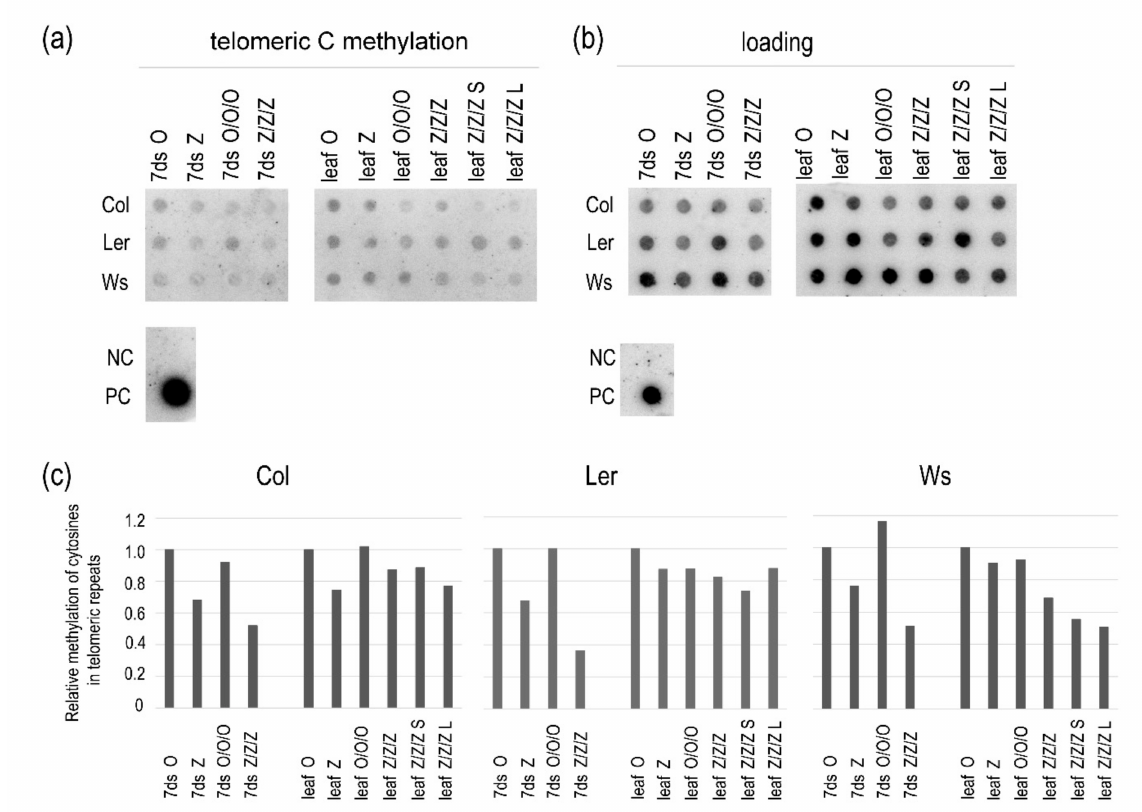
Figure 5. Relative levels of methylated cytosines in telomeric repeats in the first and third generations of 7-day-old seedlings (7ds) of A. thaliana plants germinated on control medium or exposed to 250 µ M zebularine, and in leaves of plants grown from these seedlings in soil. Mixed samples were analyzed; DNAs were isolated from 1 g of seedlings cultivated on three Petri dishes and 2 g of leaves of three plants grown from these seedlings, except of individual 3G zebularine plants with short and long telomeres (leaf Z/Z/Z S, leaf Z/Z/Z L). For bisulfite conversion, DNAs were mixed at an equimolar ratio. Bisulfite-modified DNAs were hybridized with the oligonucleotide probe reflecting fraction of telomeres with methylated cytosines ( a ), and the probe complementary to the G-strand of telomeres to determine loading ( b ). The same membrane was sequentially hybridized with both probes. PC, positive control, genomic DNA from Col leaves non-converted by sodium bisulfite; NC, negative control, pUC19 plasmid DNA. ( c ) Relative methylation of cytosines in telomeric repeats. Intensities of hybridization signals in ( a , b ) were evaluated by the MultiGauge software (FujiFilm) and expressed as the methylation/loading ratio. Signal ratios in respective control samples of the first generation (7ds O, leaf O) were arbitrarily taken as 1. For experimental design and nomenclature of samples, see Figure